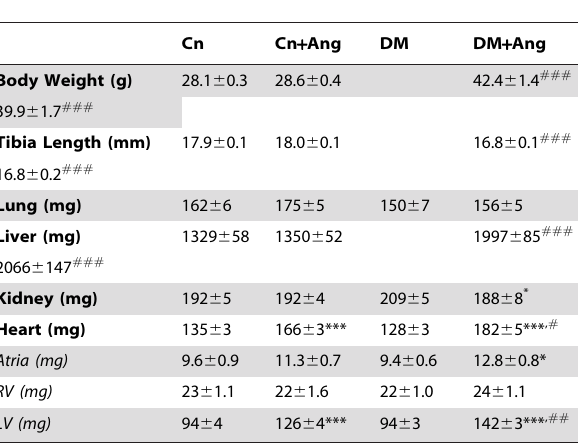
Table 1. Morphometric characteristics of non-diabetic (Cn) and diabetic (DM) mice treated with vehicle or AngII (Ang) for 4 weeks.